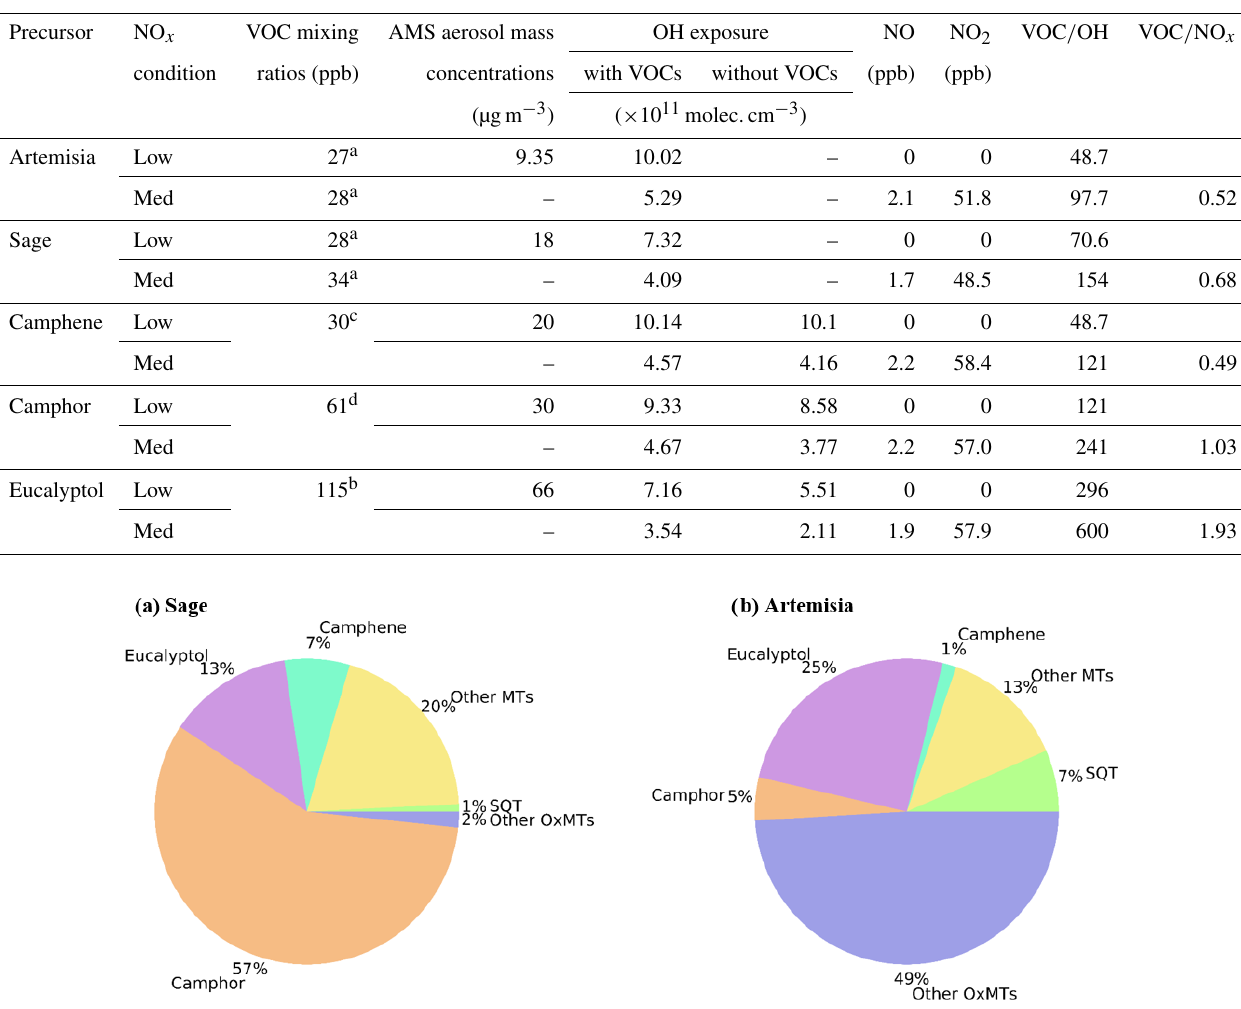
Table 2. Summary of experimental conditions, where the VOC mixing ratios denoted by a are measured by TD-GC-FID–ToF-MS, those denoted by b are estimated from syringe pump injection, those denoted by c are estimated from SOA yields of β -pinene and those denoted by d are estimated from SOA yields of plant experiments.